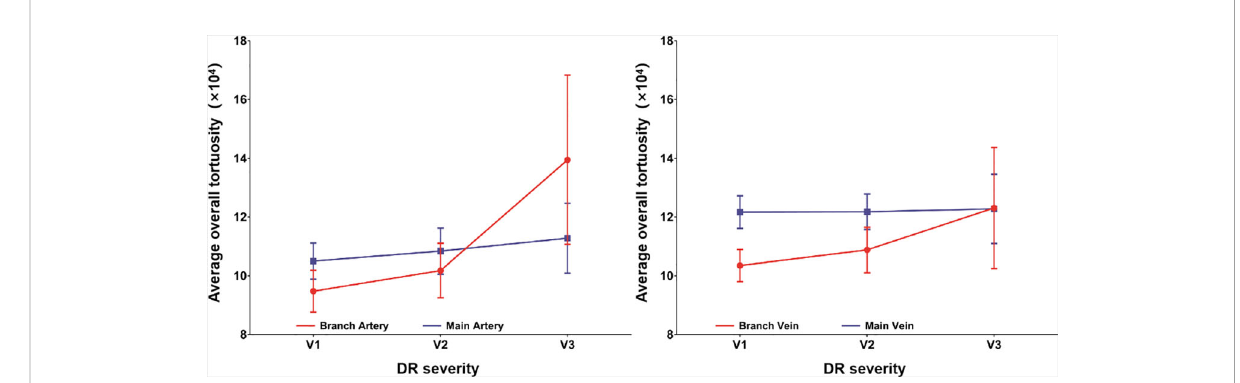
FIGURE 3 The relationship between retinal vascular tortuosity and DR